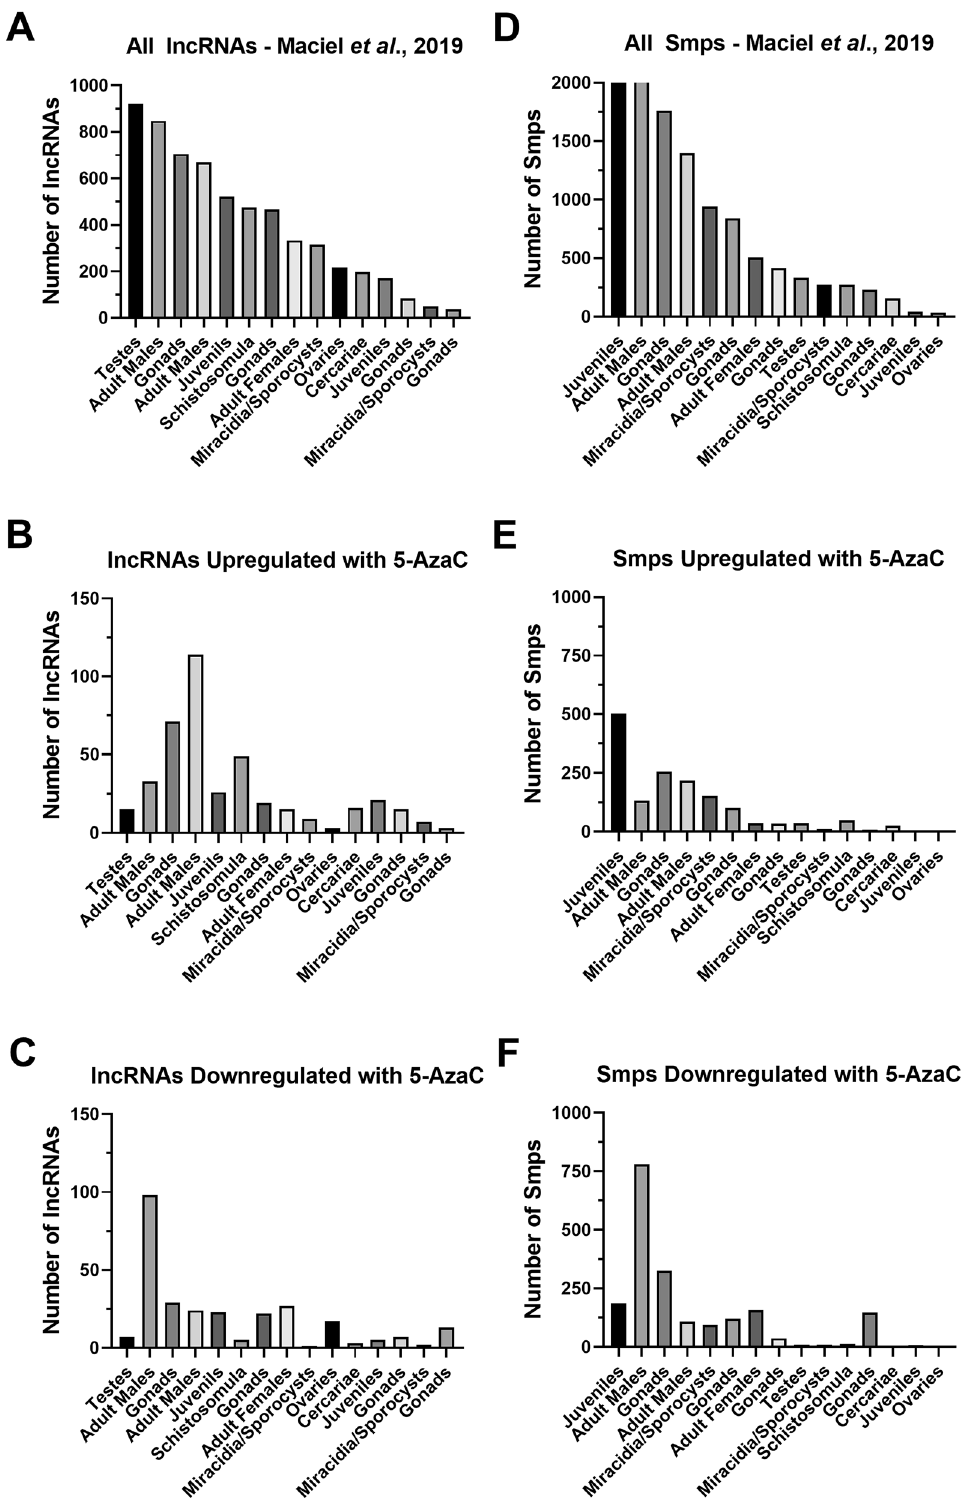
Figure 2. Distribution of 5-AzaC-affected long non-coding RNAs and protein-coding genes among the weighted gene co-expression network (WGCNA) modules (represented by life-cycle stages and tissues). ( A ) Number of lncRNAs detected in each of 15 different WGCNA modules, according to Maciel et al. 31 ; note that different modules are associated to the same S. mansoni life-cycle stage/tissue. ( B ) Number of lncRNAs upregulated in 5-AzaC treated females in each of the 15 WGCNA modules. ( C ) Number of lncRNAs downregulated in 5-AzaC treated females in each of the 15 WGCNA modules. ( D ) Number of protein-coding genes detected in each of 15 different WGCNA modules, according to Maciel et al. 31 ; note that different modules are associated to the same S. mansoni life-cycle stage/tissue. ( E ) Number of protein-coding genes upregulated in 5-AzaC treated females in each of the 15 WGCNA modules. ( F ) Number of protein-coding genes downregulated in 5-AzaC treated females in each of the 15 WGCNA